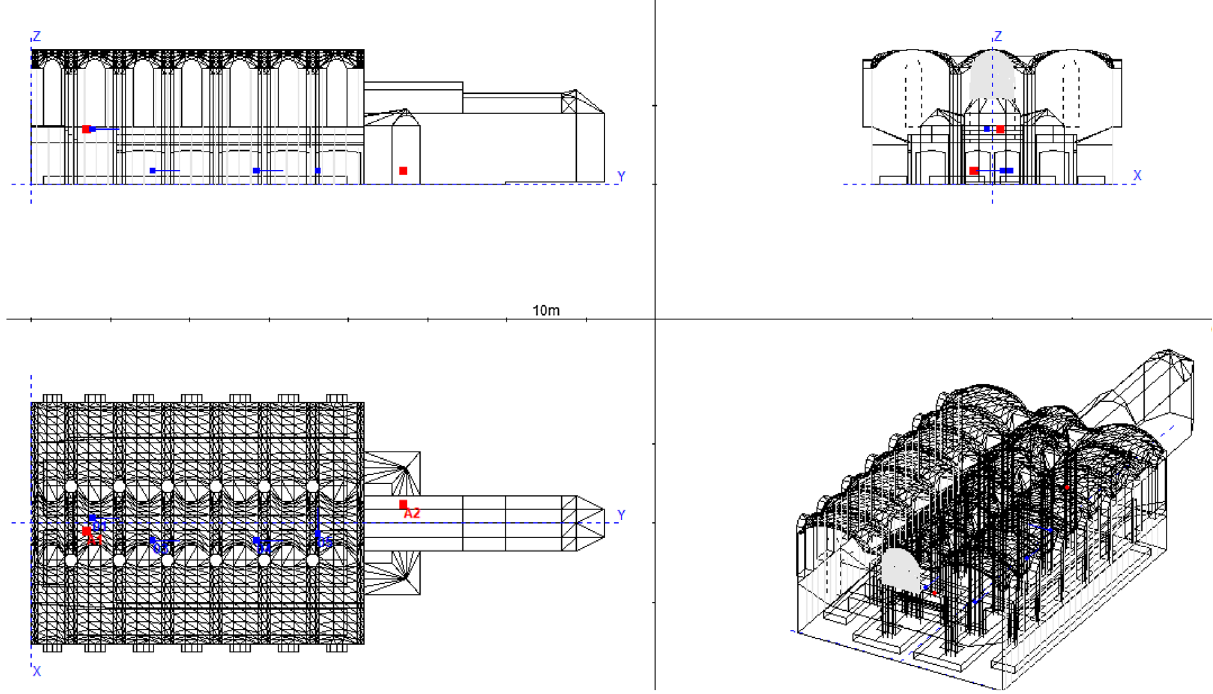
Figure 4. Geometrical model of the Thomaskirche, volume (cid:1) 16 000 m 3